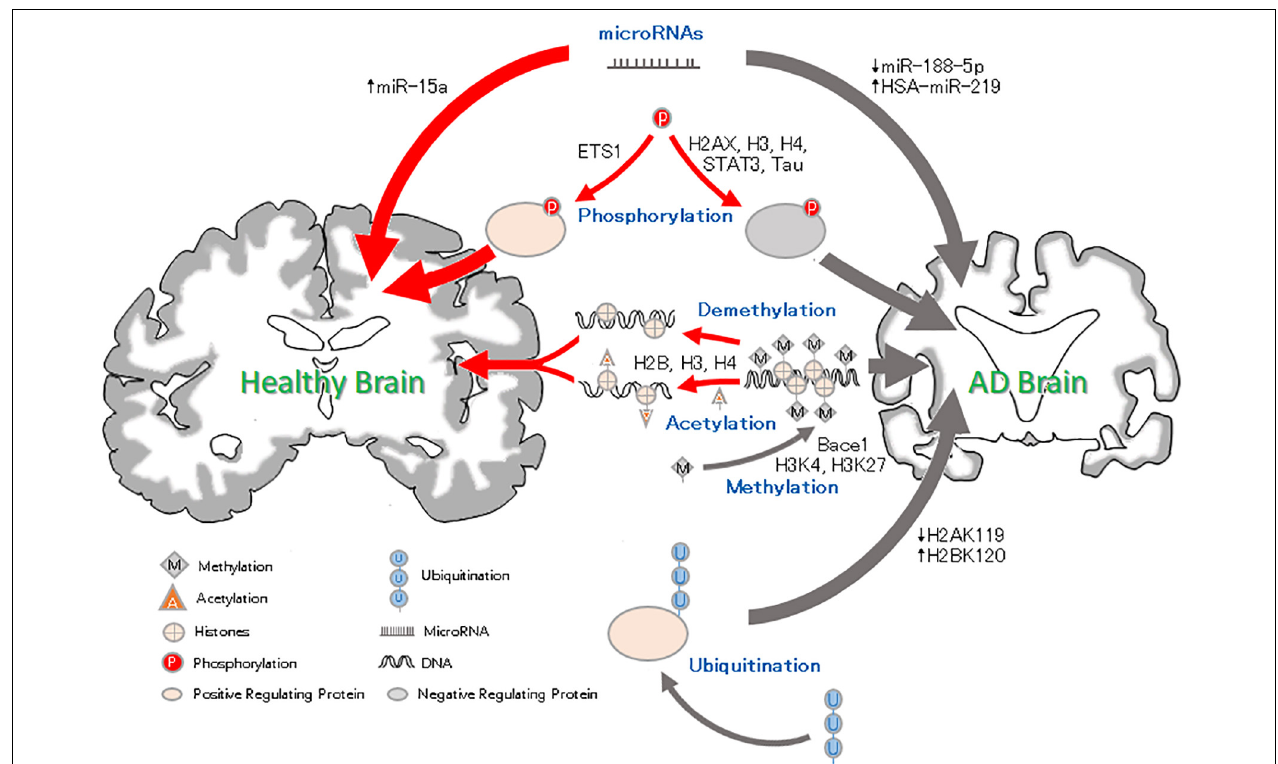
FIGURE 1 | Epigenetic factor roles in Alzheimer’s disease. Methylation and Acetylation: DNA methylation results in reduced silencing of neurodegenerative genes and affects neural development. Histone methylation may condense chromosomes, thus preventing the expression of binding genes. Histone acetylation leads to chromatin becoming more open, which promotes gene expression. Phosphorylation: Histone H2AXS139 and H3 and H4S473 phosphorylation can lead to neurodegeneration. Ets1 phosphorylation reverse the pathological AD changes. Ubiquitation: High ubiquitination of H2BK120 and low ubiquitination of H2A119 and Trk1 can be related to the pathology of AD and aggravate the AD process. MicroRNA: microRNAs can inhibit gene expression. The downregulation of miRNA-188-5p and upregulation of HAS-miRNA-219 can lead to cognitive impairment, but an increase in miRNA-15a can inhibit neuronal apoptosis and alleviate